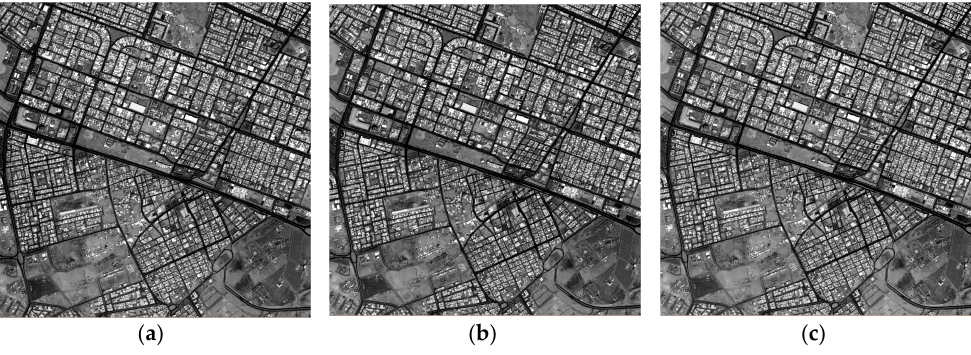
Figure 11. The raw and corrected images of the city. ( a ) Raw image; ( b ) Image corrected using the on-orbit coefficients; ( c ) Image corrected using the side-slither coefficients.